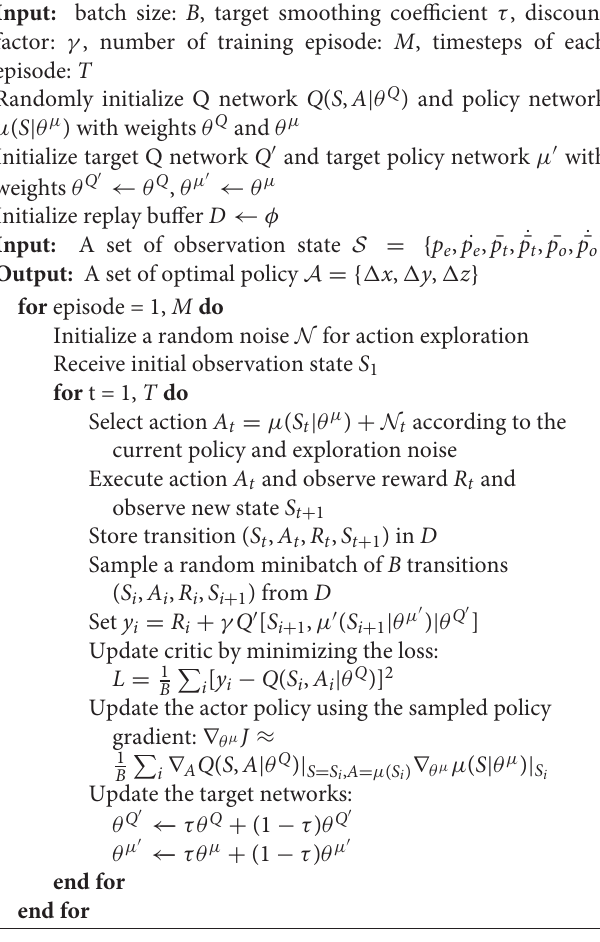
Algorithm 1 | DDPG-based trajectory